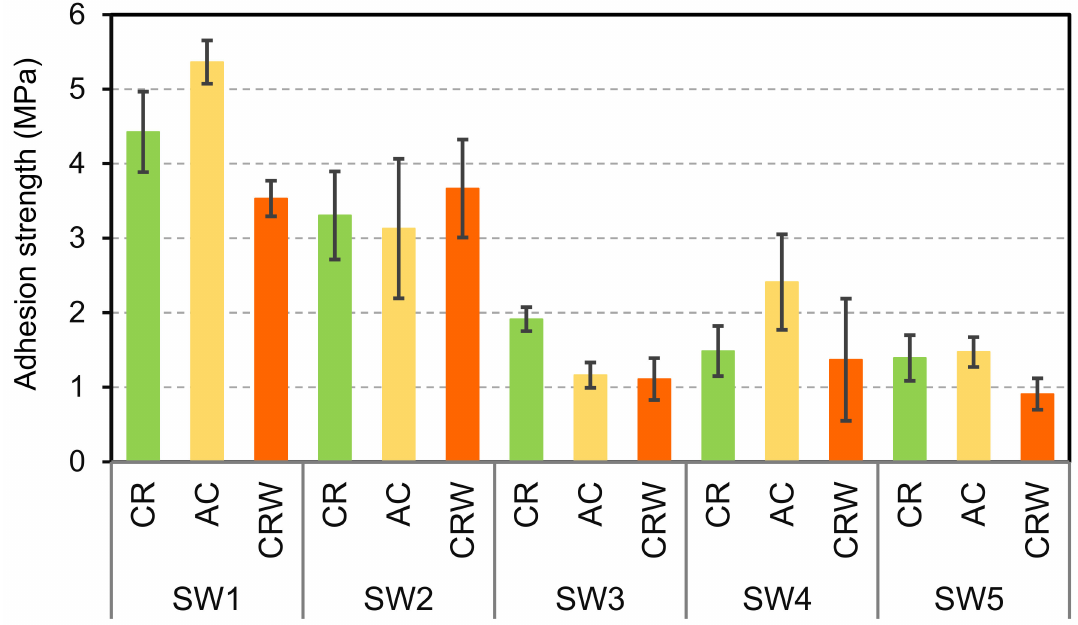
Figure 2. Adhesion strength of the coatings at the surface of beech wood. CR: curing in climate room 23 ± 2 ◦ C and 75 ± 2%RH; AC: curing in ambient conditions 23 ± 2 ◦ C and 25 ± 5%RH; and CRW: coatings cured in climate room, exposed to liquid water for three days, and dried in ambient conditions for two